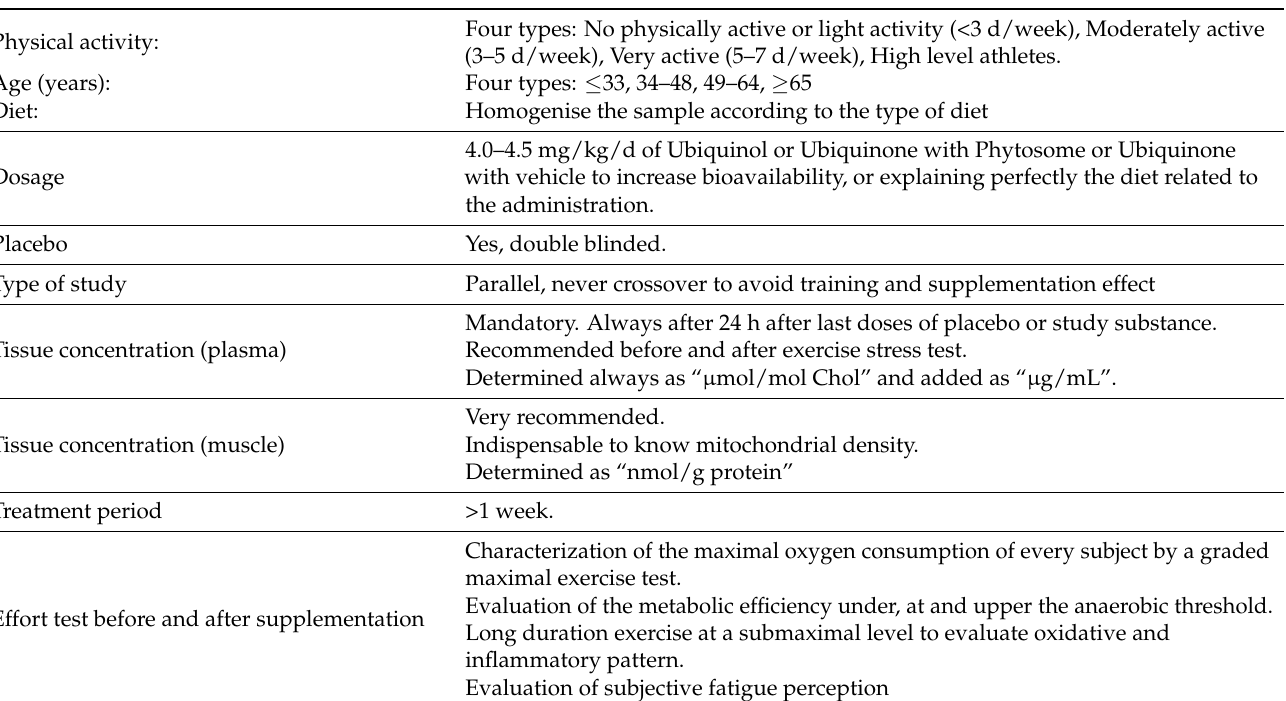
Table 12. Recommended methodological guidelines for a future study on human physical perfor- mance of CoQ 10